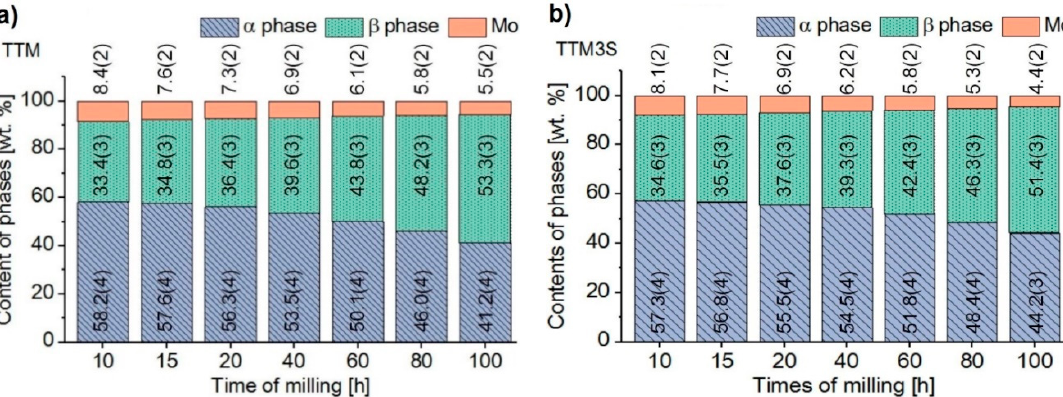
Figure 11. Changes in the weight fraction contents of the α , β and Mo phases of ( a ) TTM and ( b ) TTM3S powders after 10, 15, 20, 40, 60, 80 and 100 h of milling.